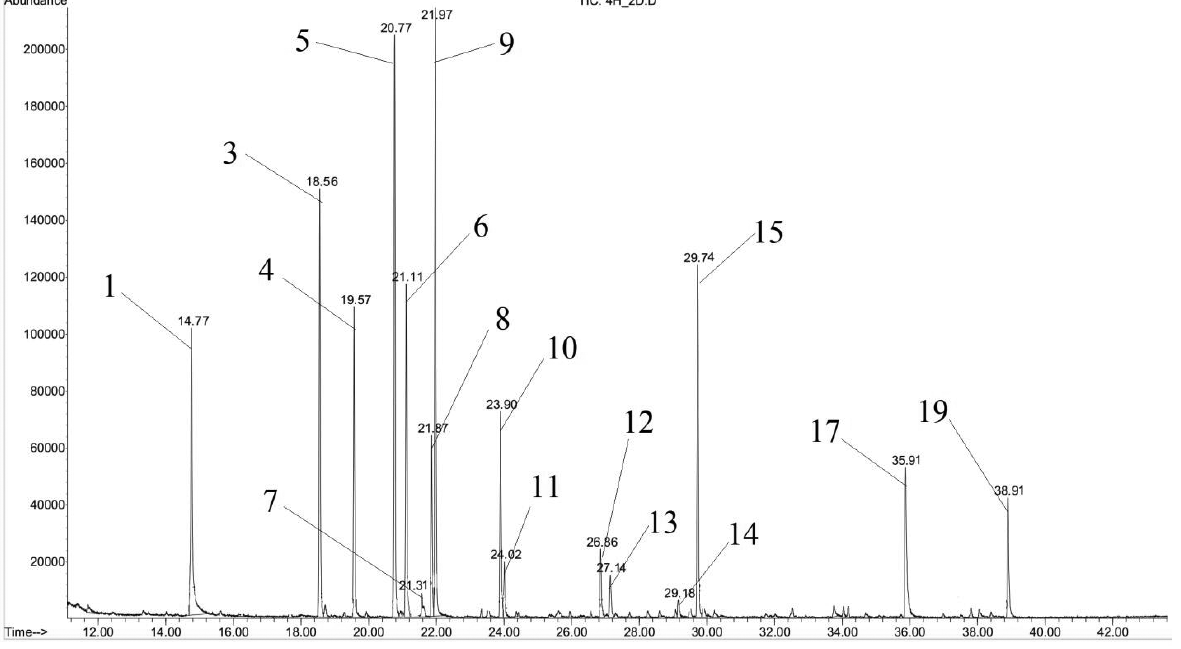
Figure 4. GC-MS chromatogram of amino acids after hydrolysis in the sample 2 of the plant